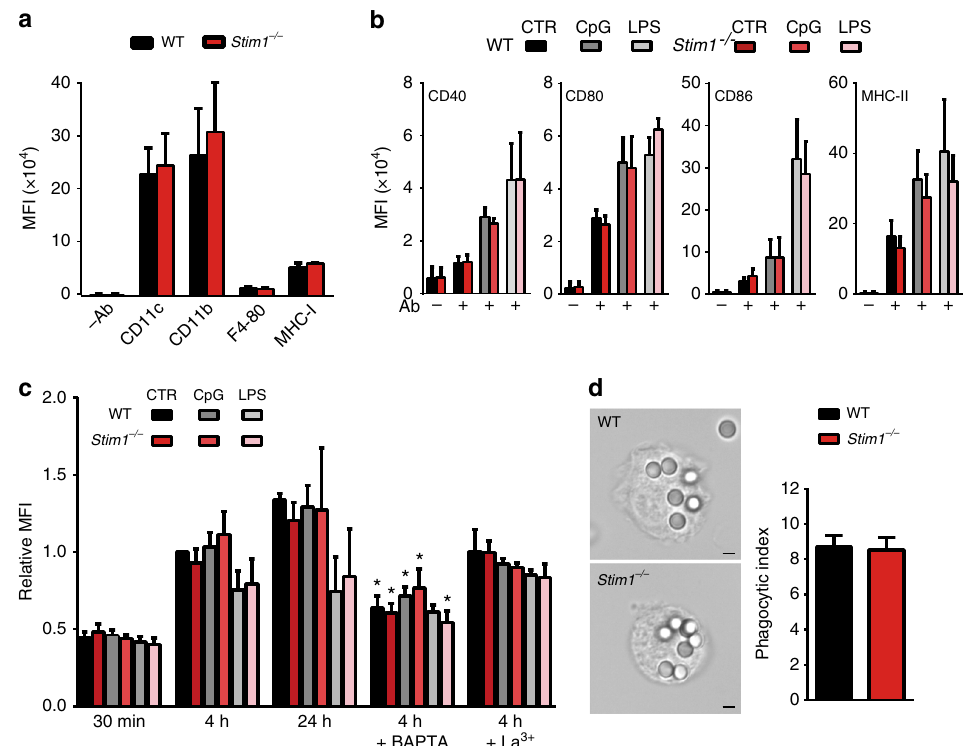
Fig. 5 Stim1 ablation does not affect BMDC differentiation, maturation, or phagocytic rate. a BMDCs express CD11c, CD11b, low levels of F4/80 and MHC-I to similar extents regardless of STIM1 expression. N = 8/5/5 for CD11c/CD11b/F4/80. Values of cellular auto fl uorescence ( − Ab) are shown for comparison. The gating strategy is shown in Supplementary Fig. 5a. b Expression of CD40, CD80, CD86 and MHC-II in immature cells or in cells matured with either CpG or LPS was similar in cells expressing or not STIM1. The full gating strategy is shown in Supplementary Fig. 2c. N = 7/5/3 for CTR/CpG/ LPS for CD40/CD80, 8/5/7 for CD86 and 8/5/5 for MHC-II. c Phagocytosis of YG- Fluoresbrite-OVA-coated beads (OVAb) was decreased by loading cells with 40 μ M BAPTA but not by exposing cells to the non-speci fi c SOCE blocker LaCl 3 (50 μ M), and was similar in immature and mature STIM1- de fi cient cells as compared to cells from wild-type littermates. N = 4/5/3/3/3 for 30 min/4 h/24 h/BAPTA/La 3+ . The full gating strategy is shown in Supplementary Fig. 2c. d The absence of phagocytic defect in STIM1-de fi cient cells was con fi rmed by quantifying phagocytosis by microscopy. Phagocytic targets added at 20:1 targets:cells. N = 3. MFI = mean fl uorescence intensity. Black bar = 3 μ m. Error bars are means + SEM, * p < 0.5 using a Student ’ s t